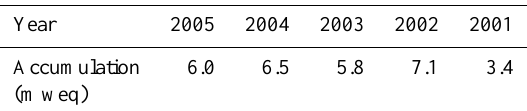
Fig. 7. Stake network (solid black circles) deployed around the drilling site (empty circle with x). The numbers at each stake represent snow accumulation in cm/day. The thick blue line shows the location of a prominent ridge which marks the ice divide between Pío XI Glacier and Viedma Glacier to the north and to the east. The brown lines are contour lines with elevations in m a.s.l., obtained from the SRTM 2000 data. All stakes located lower than 2600 m were lost due to snow burial, showing a snow accumulation larger than 7 cm/day. At the highest stake, snow accumulation was practically zero, which is due to enhanced wind in the proximity of the ridge. The background image is a Quickbird scene of 26 December 2004, obtained from Google Earth, which shows a crevasse immediately Northeast of the ridge, and some rock outcrops farther downslope. Table 1. Net annual accumulation at Pío XI for the individual years for the period February 1–31